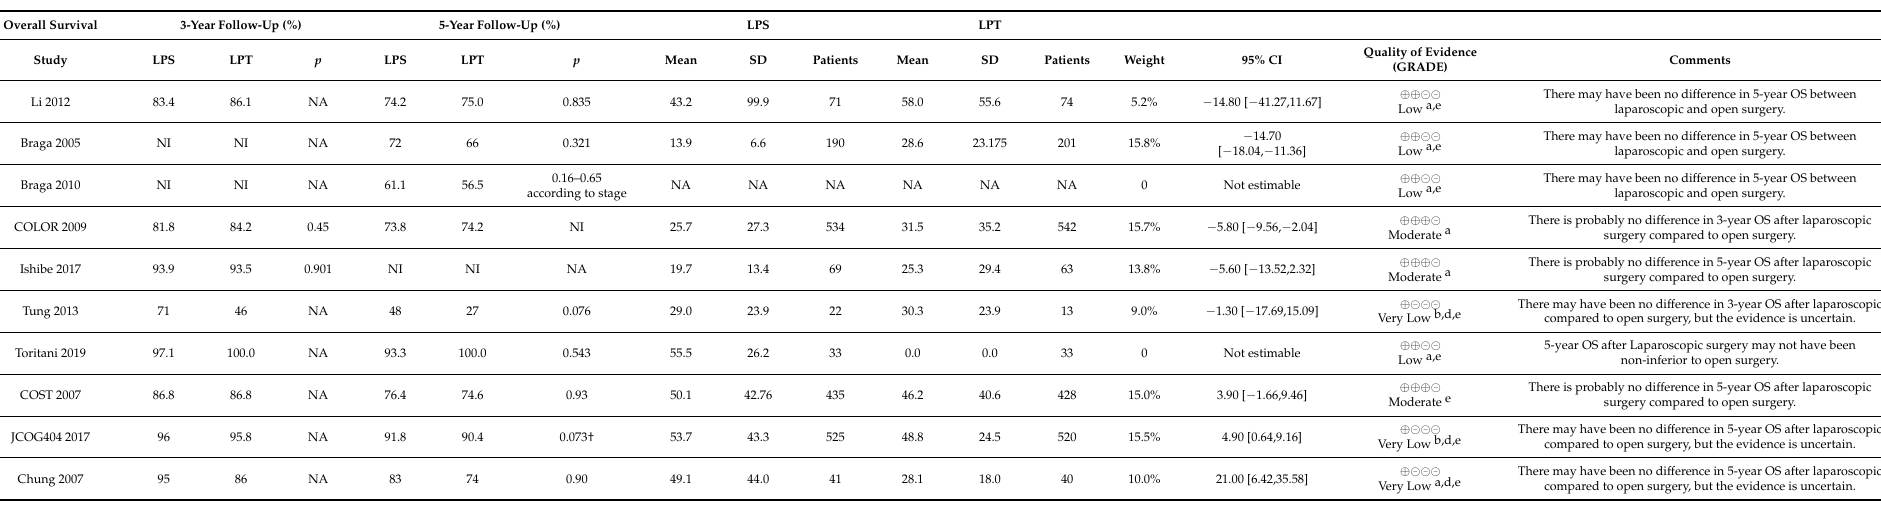
Table 3. Summary of overall survival at 3 and 5 years and quality of evidence. Data extracted from Kaplan–Meier curves using GetData Graph Digitizer. Excluding patients with stage IV